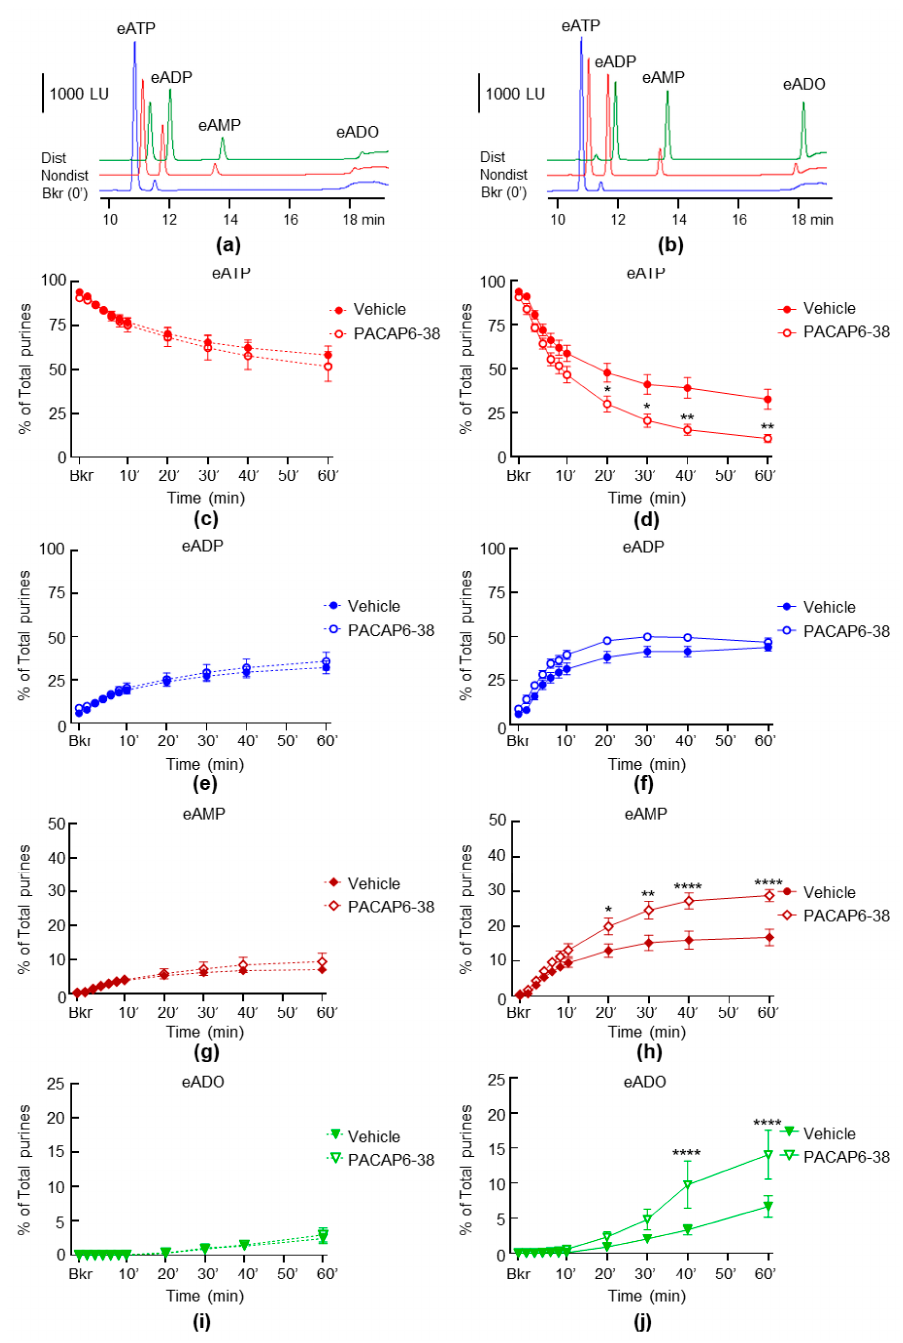
Figure 9. Effects of PACAP6-38 on the hydrolysis of eATP by s-ENTDs released in cELS of non- distended and distended detrusor-free bladder preparations. Original chromatograms of eATP in beaker (Bkr, blue, 0 ′ , no enzyme present) and at 60 min of enzymatic reaction in cELS of nondistended (Nondist, red) and distended (Dist, green) bladder preparations treated with vehicle ( a ) or PACAP6-38 ( b ). LU, luminescence units. Summarized data showing changes in eATP, eATP, eADP, eAMP and eADO in the presence of vehicle (KBS, n = 8) and PACAP6-38, 0.3 µM ( n = 5) in nondistended ( c , e , g , i ) and distended ( d , f , h , j ) bladder preparations; n , number of bladder preparations. eATP, eADP, eAMP and eADO are presented as percentages of total purines (eATP + eADP + eAMP + eADO) present in reaction solutions. Asterisks denote significant difference from vehicle controls. * p < 0.05, ** p < 0.01, **** p < 0.0001. Two-way ANOVA with Sidak’s multiple comparisons tests.